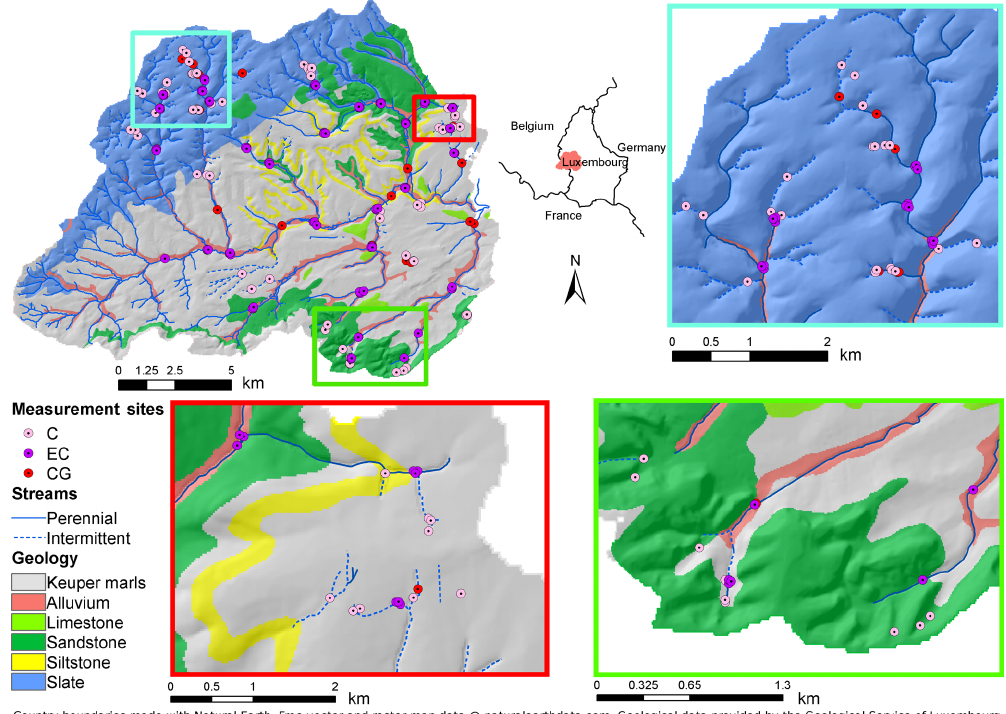
Figure 1. Geology and stream network of the Attert basin and streamflow monitoring sites. Monitoring sites are categorised into time-lapse camera (C), electric conductivity measurements (EC) and conventional discharge gauging systems (CG). Detailed maps show the more densely equipped areas in each predominant geology: slate (blue box), marls (red box) and sandstone (green box). The geological map from 1947 was provided by the Geological Service of